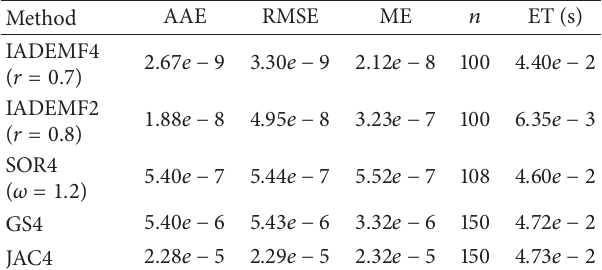
Figure 8: Numerical and exact solutions for Experiment 2. 𝜆 = 0.5 , Δ𝑥 = 0.1 , Δ𝑡 = 0.005 , 𝑡 = 0.25 , and 𝜀 = 10 −4 .